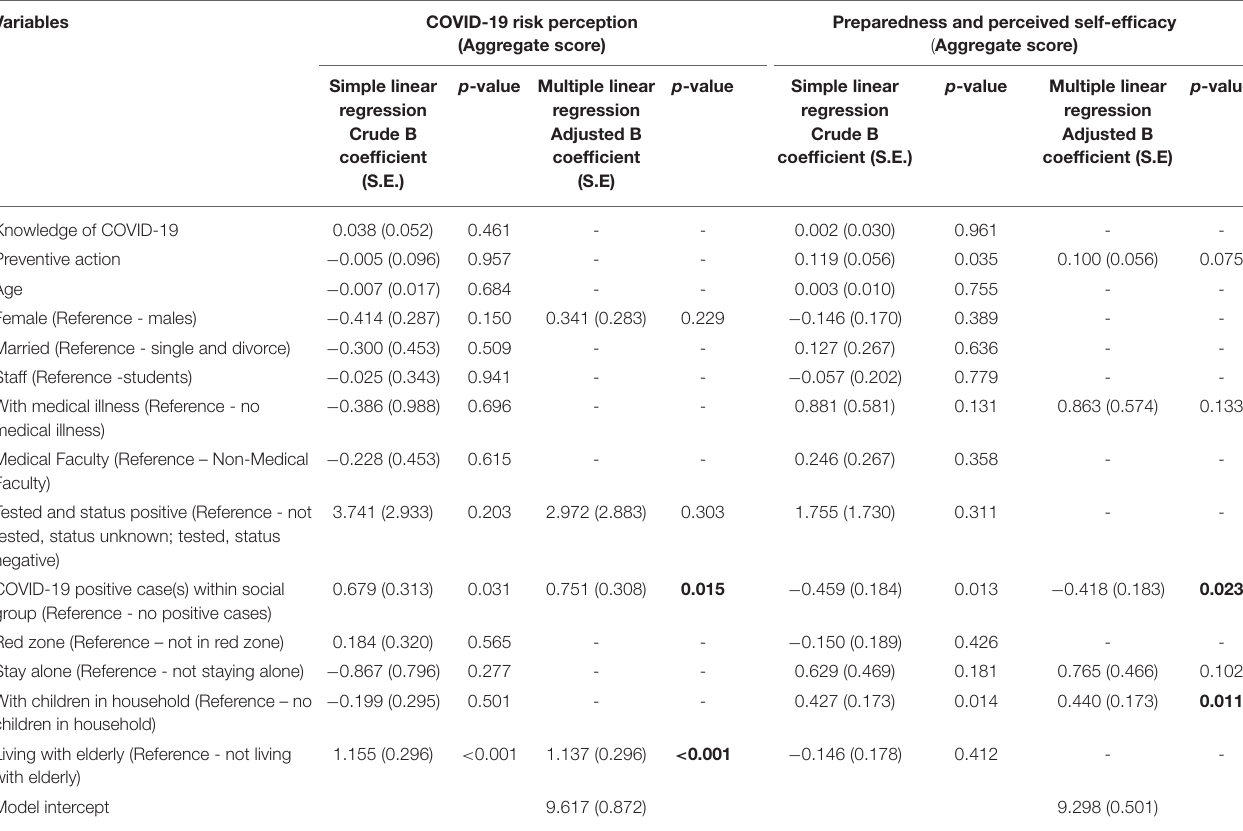
TABLE 8 | Factors associated with risk perception and with preparedness & perceived self-efficacy ( n =